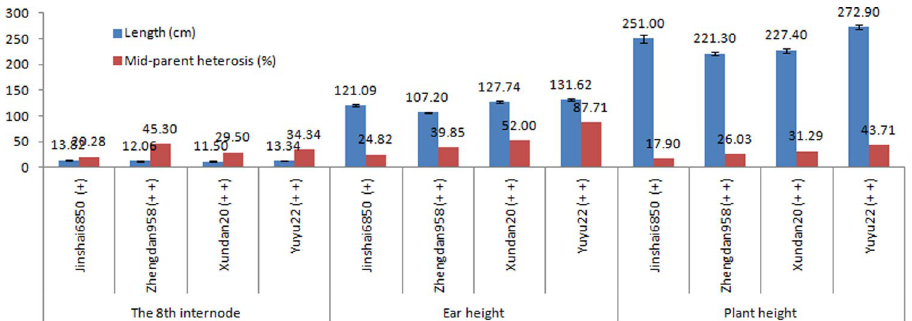
Figure 2. Comparison of internode length and plant height between the hybrids and parental inbred